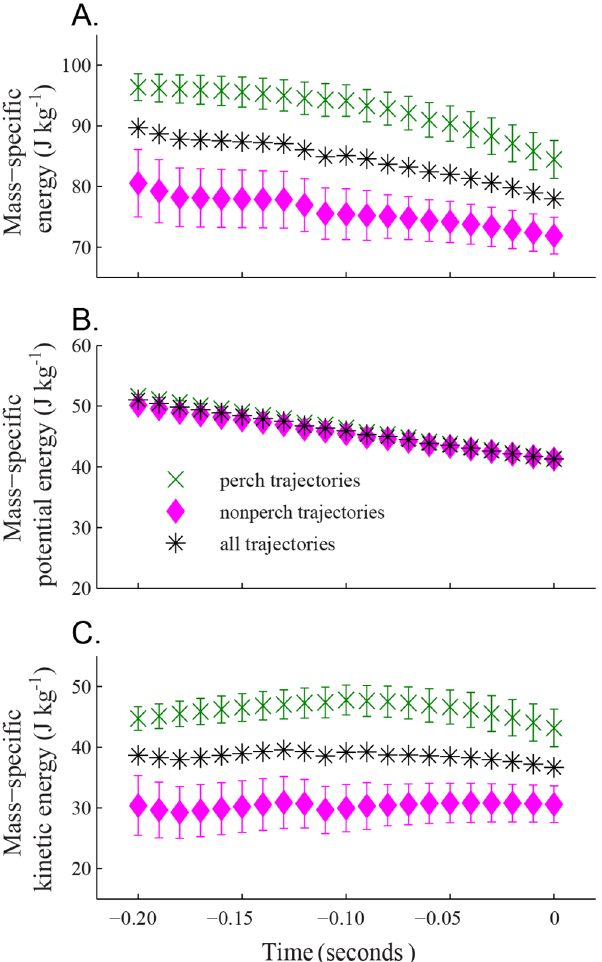
Fig 8. Kinetic and potential energy in defending trajectories. Here we show the (A) mass-specific energy, (B) potential energy, and (C) kinetic energy of trajectories from hummingbirds defending the feeder. The green cross markers show data from defending birds that approached the feeder from a specific perch (n = 16 trajectories at t d = 0 and n = 15 at (cid:3) -0.11 seconds). The pink diamond markers show all other defending trajectories (n = 17 at t d = 0, n = 15 at -0.09 to -0.20 seconds, and n = 11 at -0.20 seconds). The black asterisk marker represents all defending trajectories (n = 31 at time zero, n = 30 at -0.09 to -0.20 seconds, and n = 26 at -0.20 seconds). Error bars show the standard error about the mean for perch and nonperch trajectories. Unlike our treatment of departing bird potential energy, in (B) the starting positions of the birds were not set to a common identical initial value but are nevertheless quite